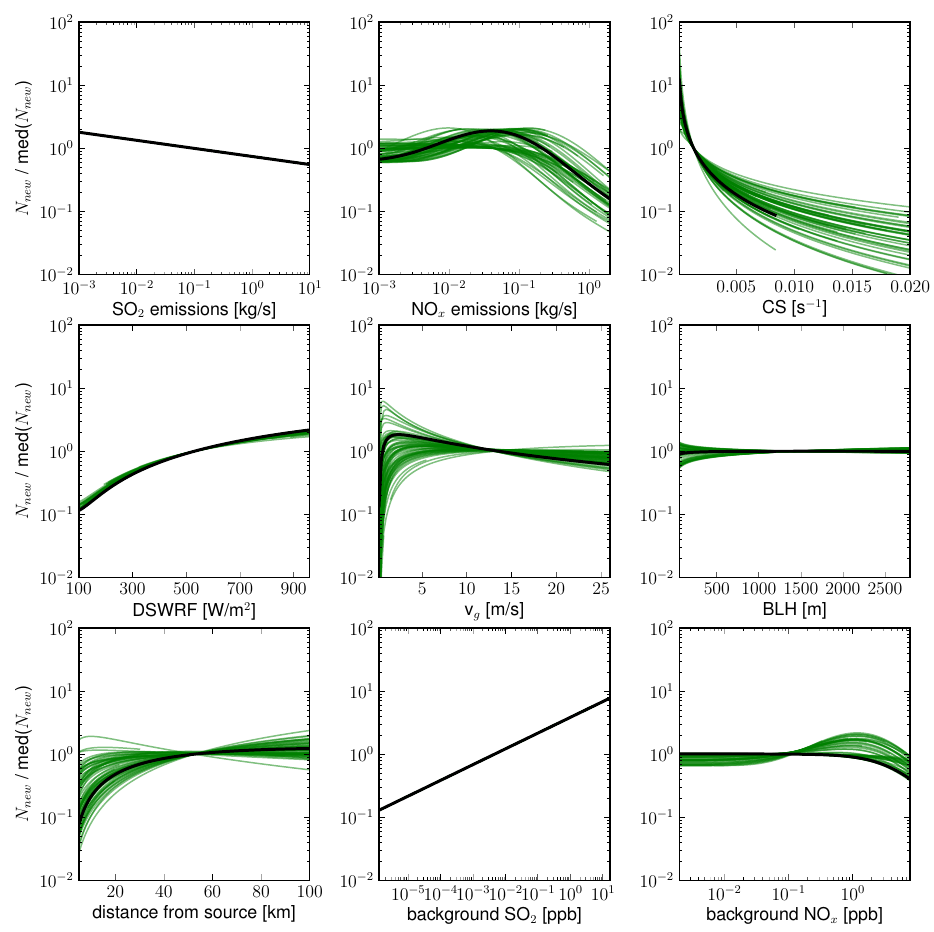
Fig. 4. Sensitivity of N new to each of the inputs for 100 randomly selected sample inputs. If nucleation is not predicted by the P6 parameteri- zation, no value is shown. The black line denotes the median value case. Each plotted line is divided by its median value in order to highlight the sensitivities to the